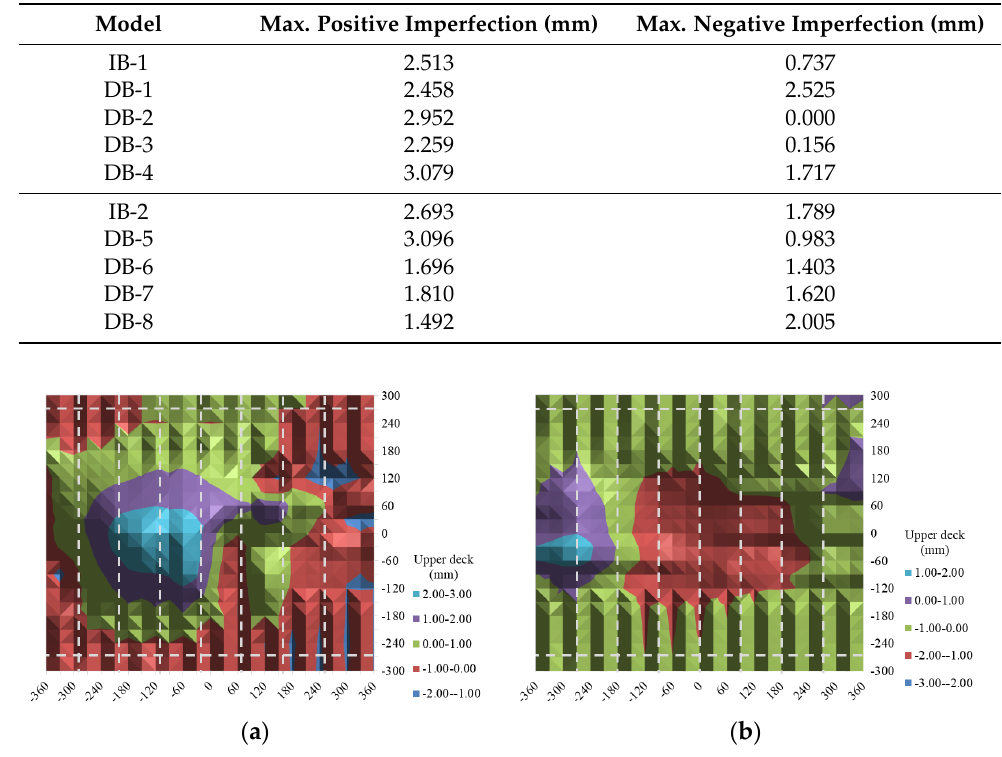
Figure 3. Plots of the initial imperfection measurement: ( a ) IB - 2; ( b ) DB - 8 (dotted line represents the longitudinal stiffeners and transverse